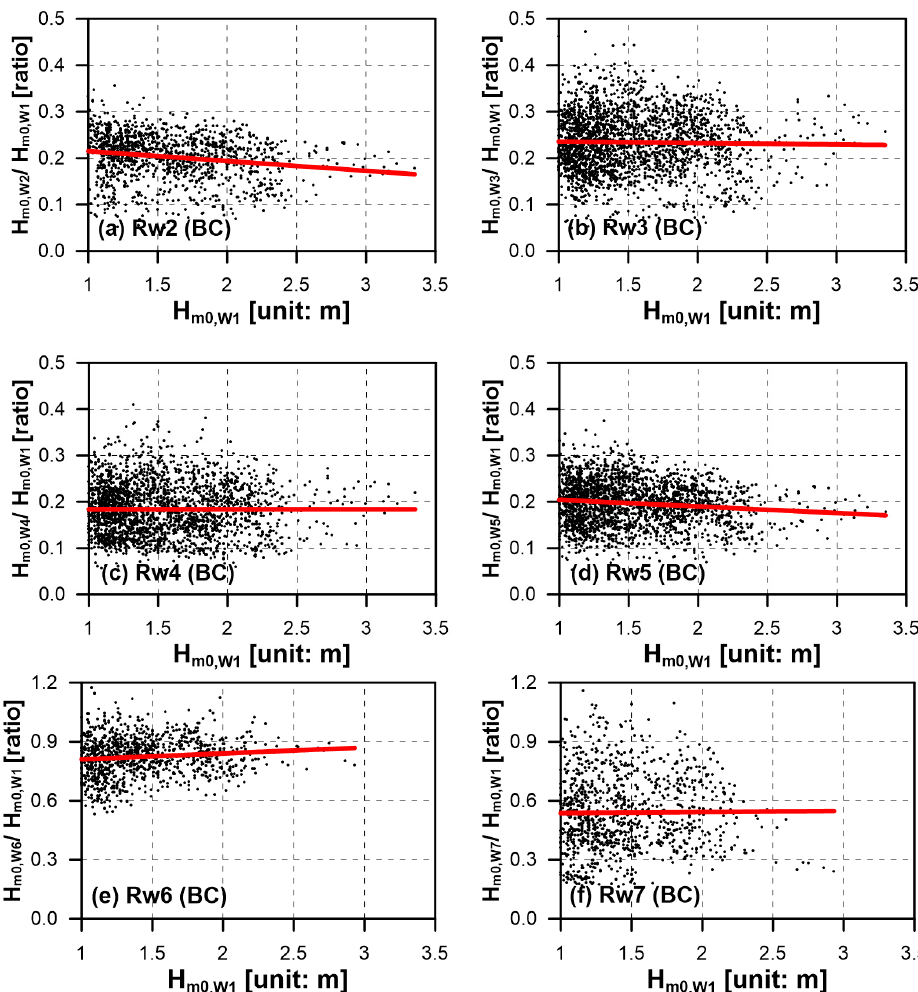
Figure 10. Same as Figure 8, but the x-axis is H m 0 measured in W1 in BC. ( a ) R W 2 vs. H m 0 , ( b ) R W 3 vs. H m 0 , ( c ) R W 4 vs. H m 0 , ( d ) R W 5 vs. H m 0 , ( e ) R W 6 vs. H m 0 , ( f ) R W 7 vs. H m 0 .The correlation between R W # and the wave propagation direction ( D p , W 1 ) observed in Figures 8 and 9 was not found in the case of the wave height ( H m 0